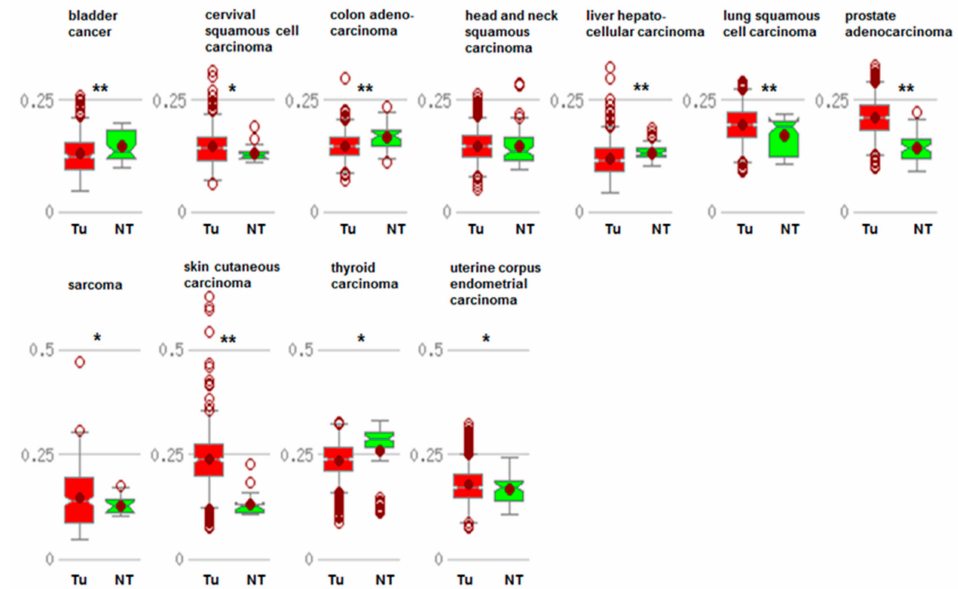
Figure 1. Comparison of average CDKN1A gene expression in a tumor sample (Tu) and matched normal samples (NT) in a panel of di ff erent tumor types. Data were taken from the MethHC database (http: // methhc.mbc.nctu.edu.tw / ) for p21 cip1 / waf1 (NM-000389). * p < 0.05; ** p < 0.005.